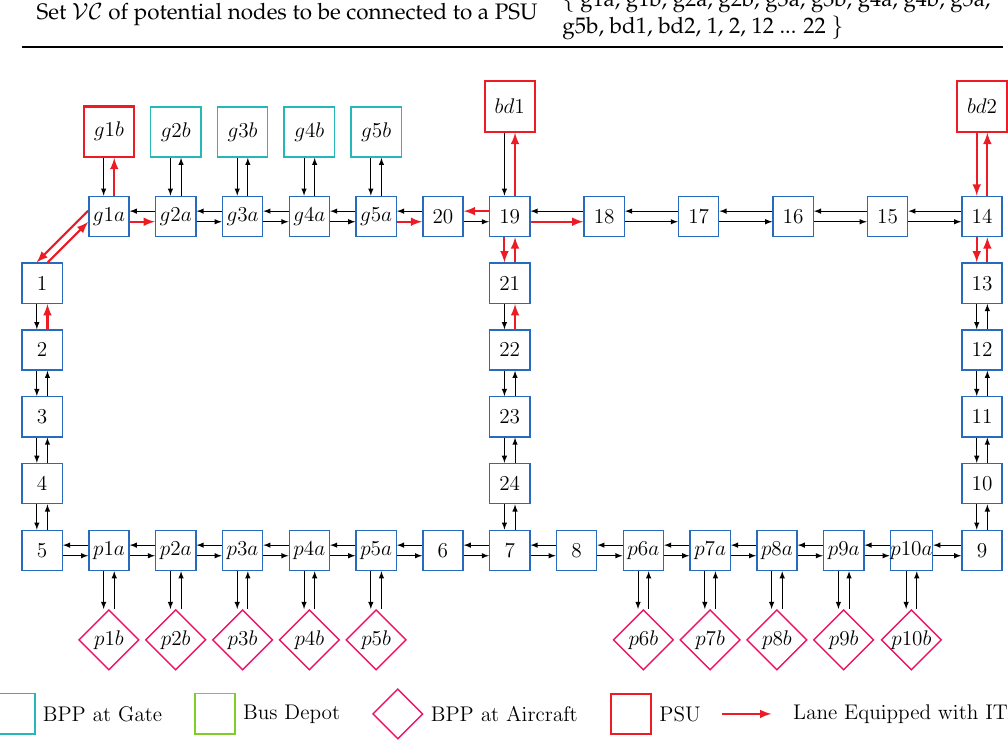
Figure 10. Allocation of system components for Case A (relatively inexpensive